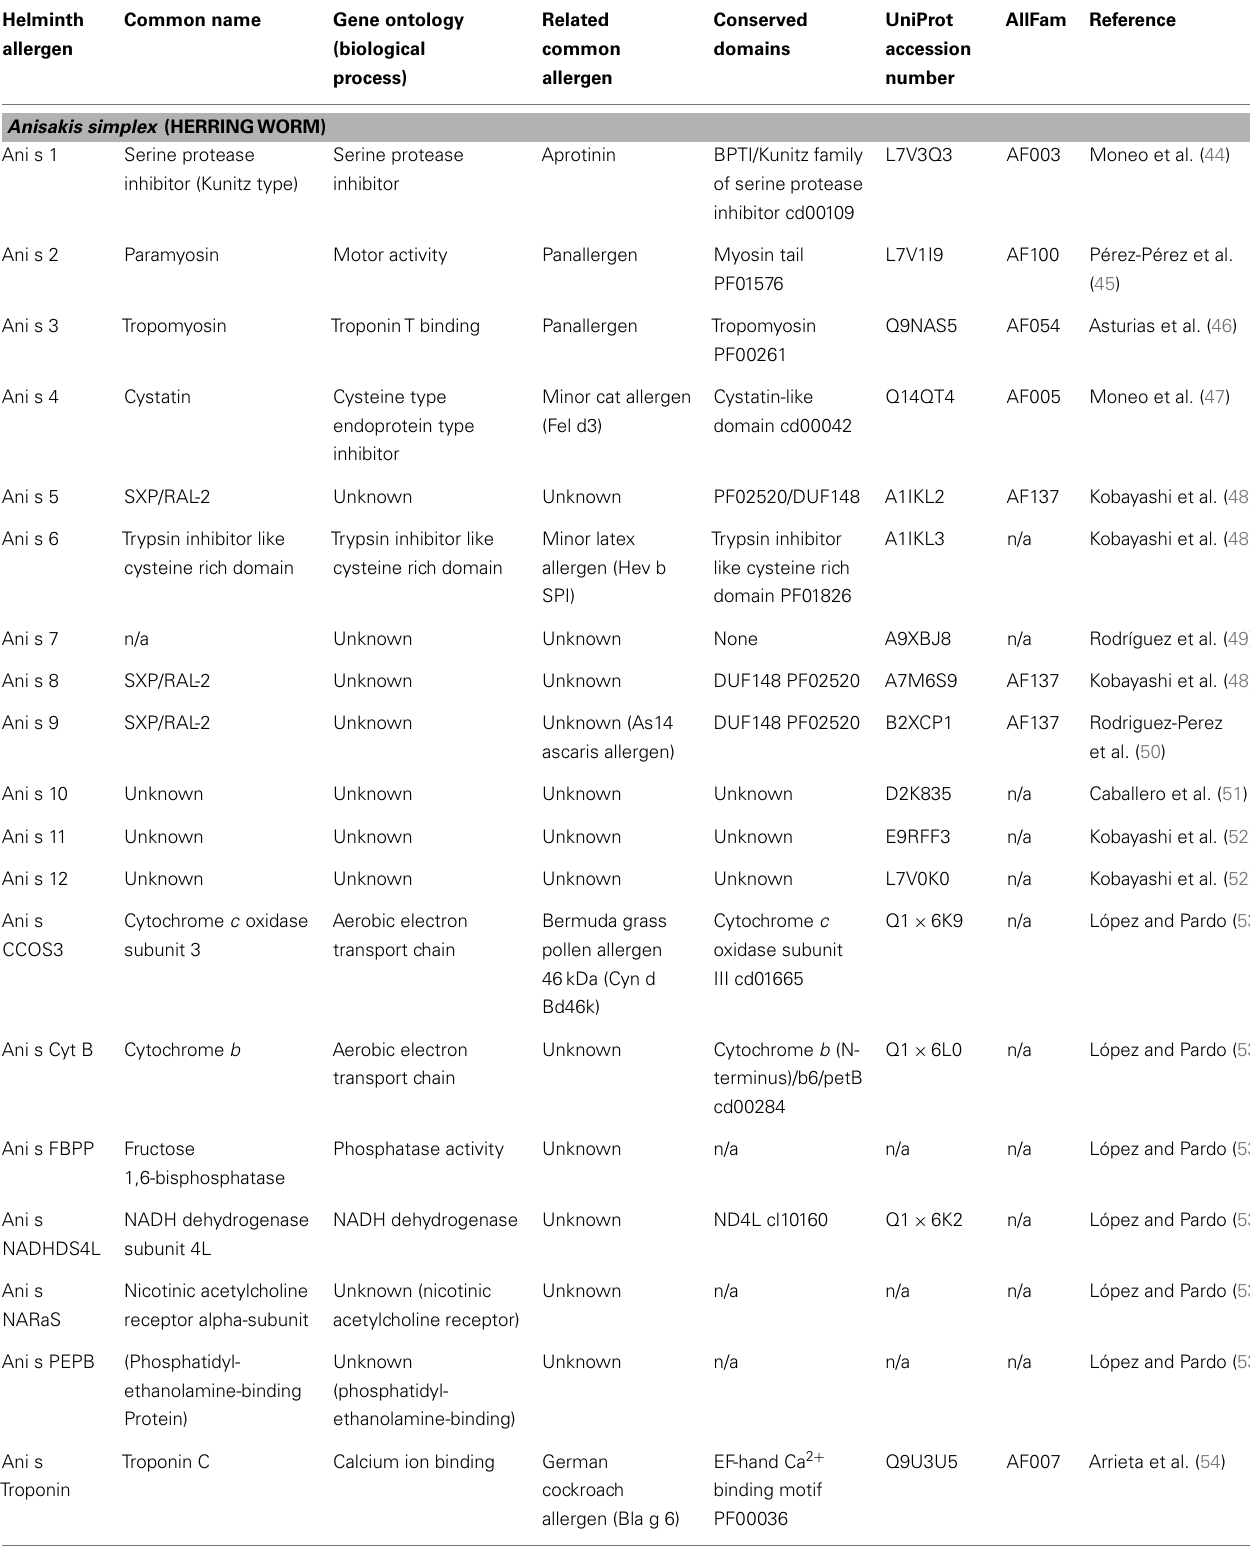
Table 1 | Summary of helminthic